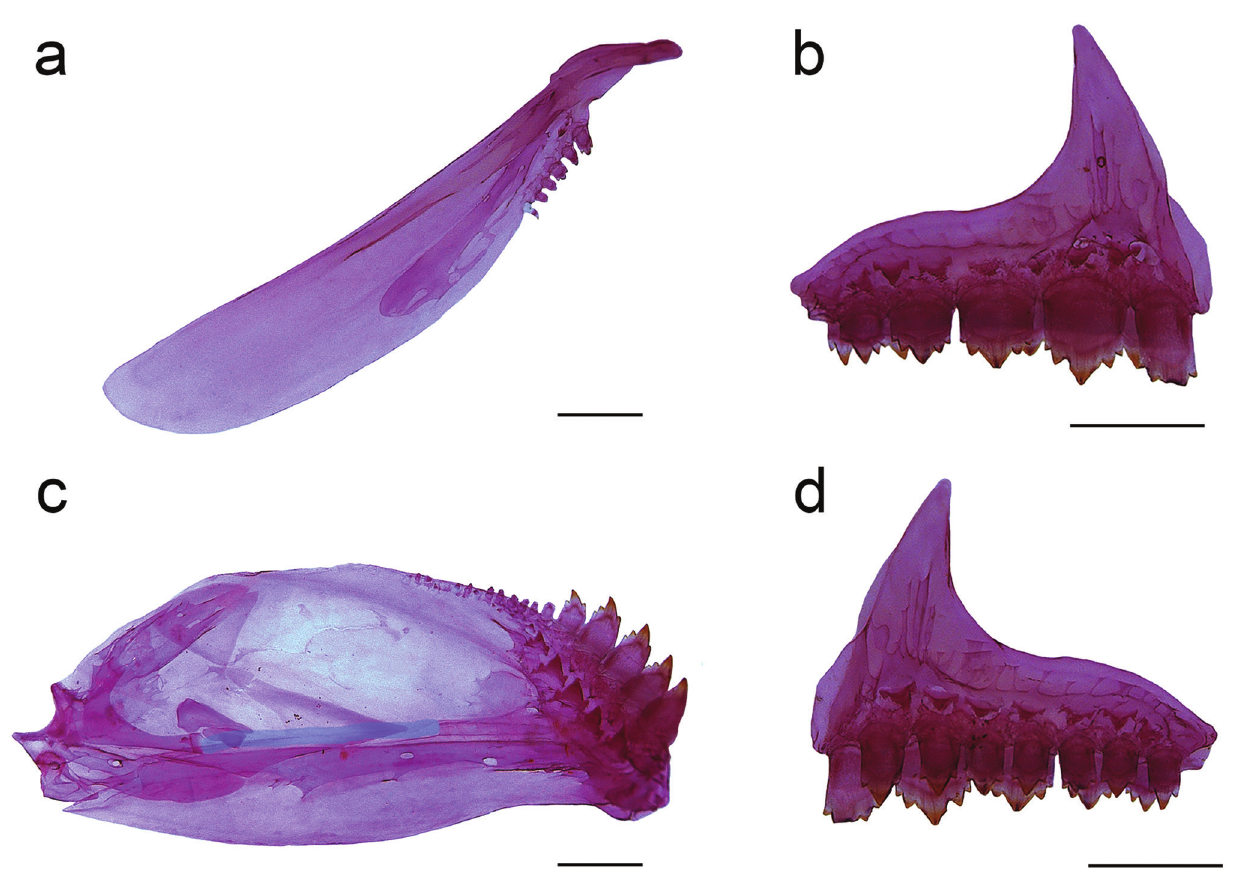
Fig. 3. Left side dentition of Tetragonopterus manaos , MZUSP 121680, paratype, 56.1 mm SL. Medial view of a. maxilla, b. premaxilla, c. dentary, and d. lateral view of premaxilla. Scale bars = 1